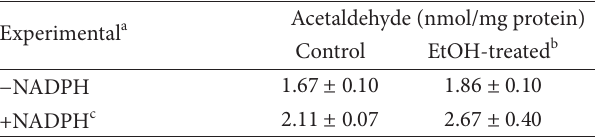
Table 2: Ethanol metabolism to acetaldehyde in the microsomal fraction of uterine horn tissue from rats receiving an alcohol containing liquid diet.